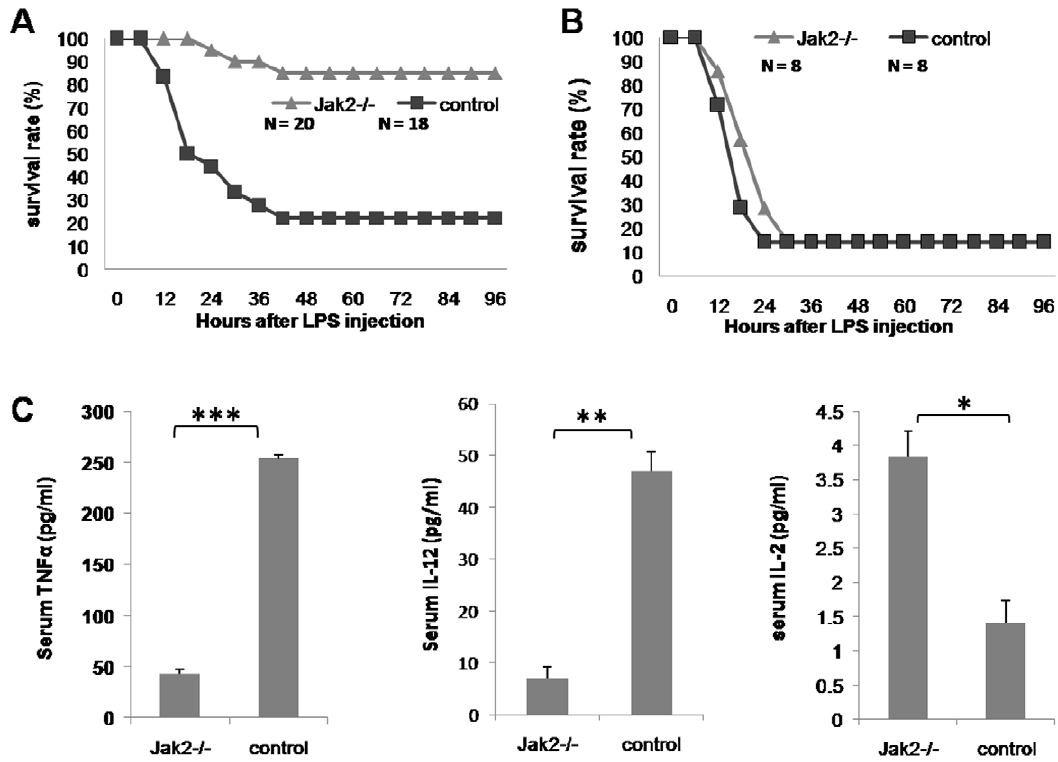
Figure 4. Jak2 2 / 2 mice show DC-dependent resistance to lethal dose of LPS-induced septic shock. (A) The survival rates of Jak2 2 / 2 and control mice were monitored for 4 days after lethal dose of LPS challenge. It was noticed that mice would completely recover from septic shock if they did not die within 36 h of lethal dose of LPS challenge. 85% of Jak2 2 / 2 mice (17 out of 20) have completely recovered from septic shock, while only 22% of control mice (4 out of 18) have survived ( p , 0.0001). (B) Adoptive transfer of normal DCs into irradiated Jak2 2 / 2 mice restored their susceptibility to LPS-induced septic shock. Irradiated Jak2 2 / 2 or control mice were first adoptively transferred with 1 6 10 7 normal BMDCs followed by lethal dose of LPS challenge. Jak2 2 / 2 mice after adoptive transfer of normal DCs showed similar survival rate as that of control mice, indicating that the resistant phenotype for septic shock seen in Jak2 2 / 2 mice is DC-dependent. (C) ELISA analysis of serum cytokines of nonlethal dose of LPS challenged mice. Both Jak2 2 / 2 and control mice were first challenged with nonlethal dose of LPS (150 m g/mouse) and 12 h later the mice were sacrificed, respectively. Sera were pooled from three mice and then subjected to ELISA analysis of cytokine production. Three pools were analyzed for each study group. Jak2 2 / 2 mice produced significant lower levels of proinflammatory cytokines as compared with that of control mice. The data are present as mean 6 SE of three replicates. *, p , 0.05; **, p , 0.01; ***, p , 0.001.